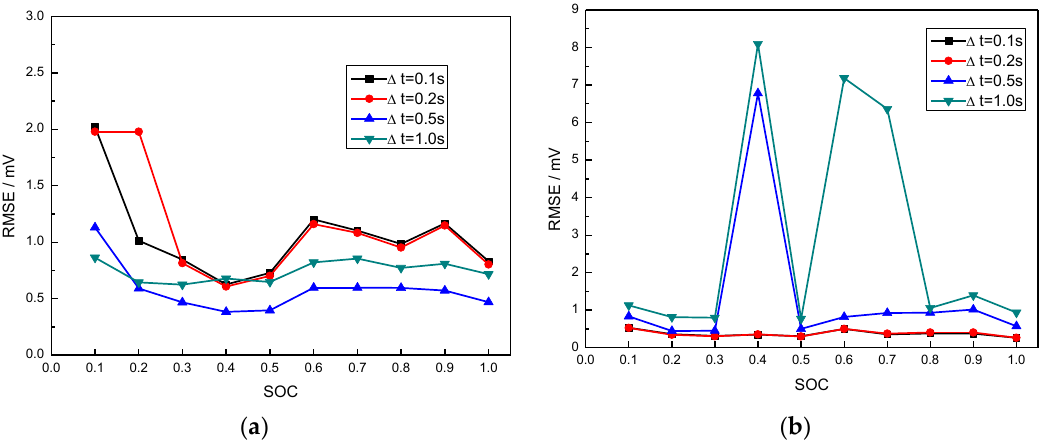
Figure 6. RMSE between the tested terminal voltage and fitted terminal voltage: ( a ) 1-RC circuit model; ( b ) 2-RC circuit model.